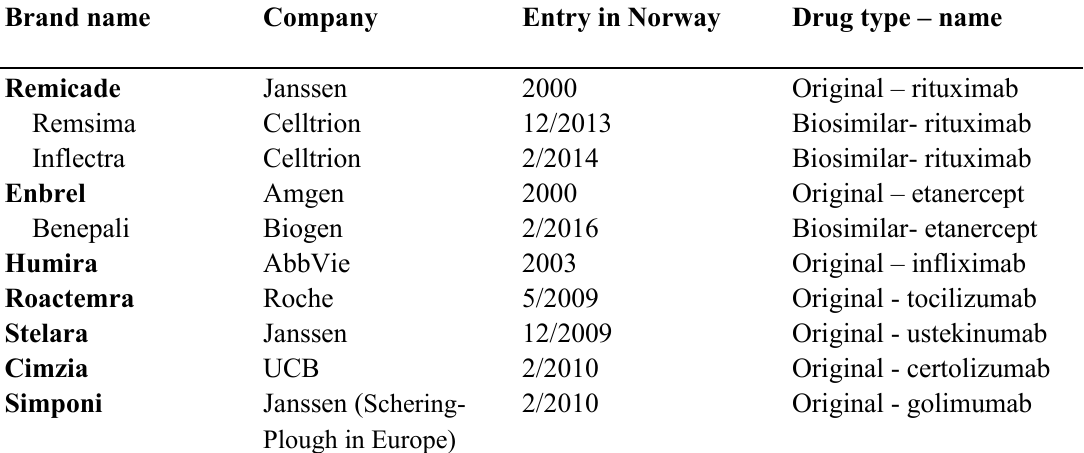
Table 1: Biologics included in the